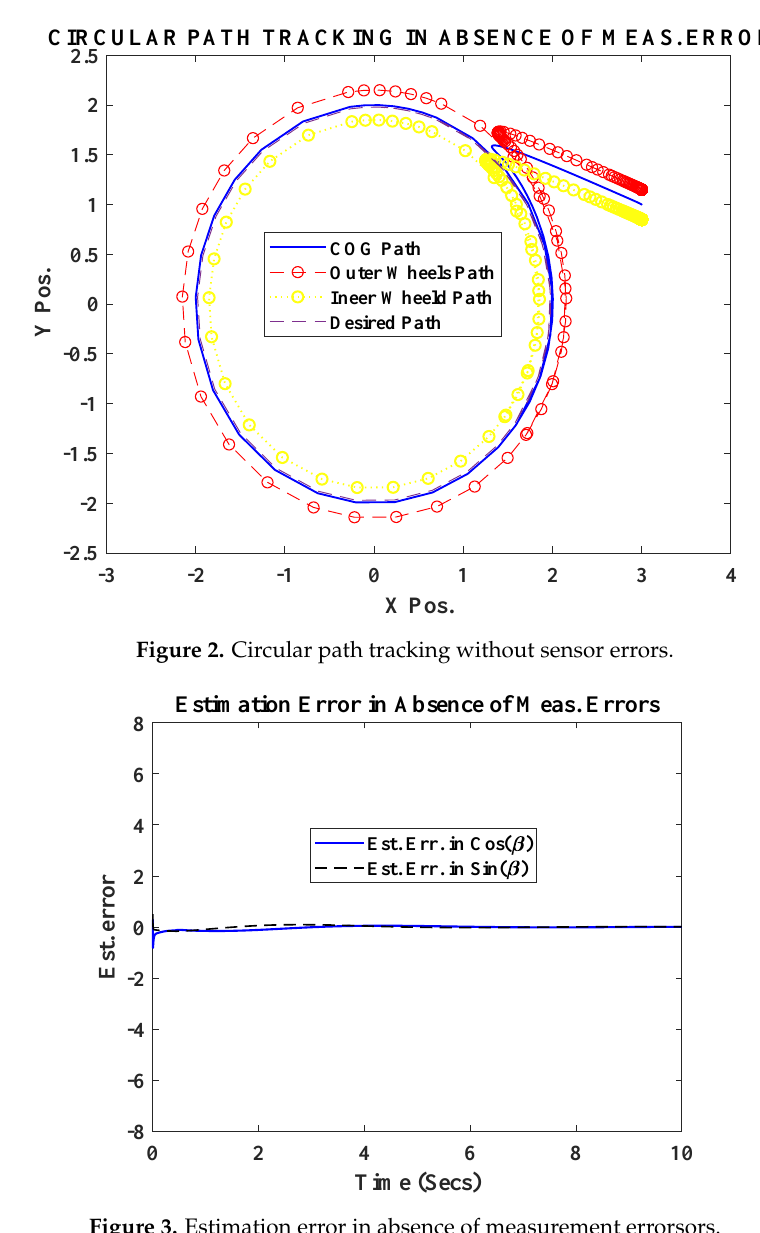
Figure 3. Estimation error in absence of measurement